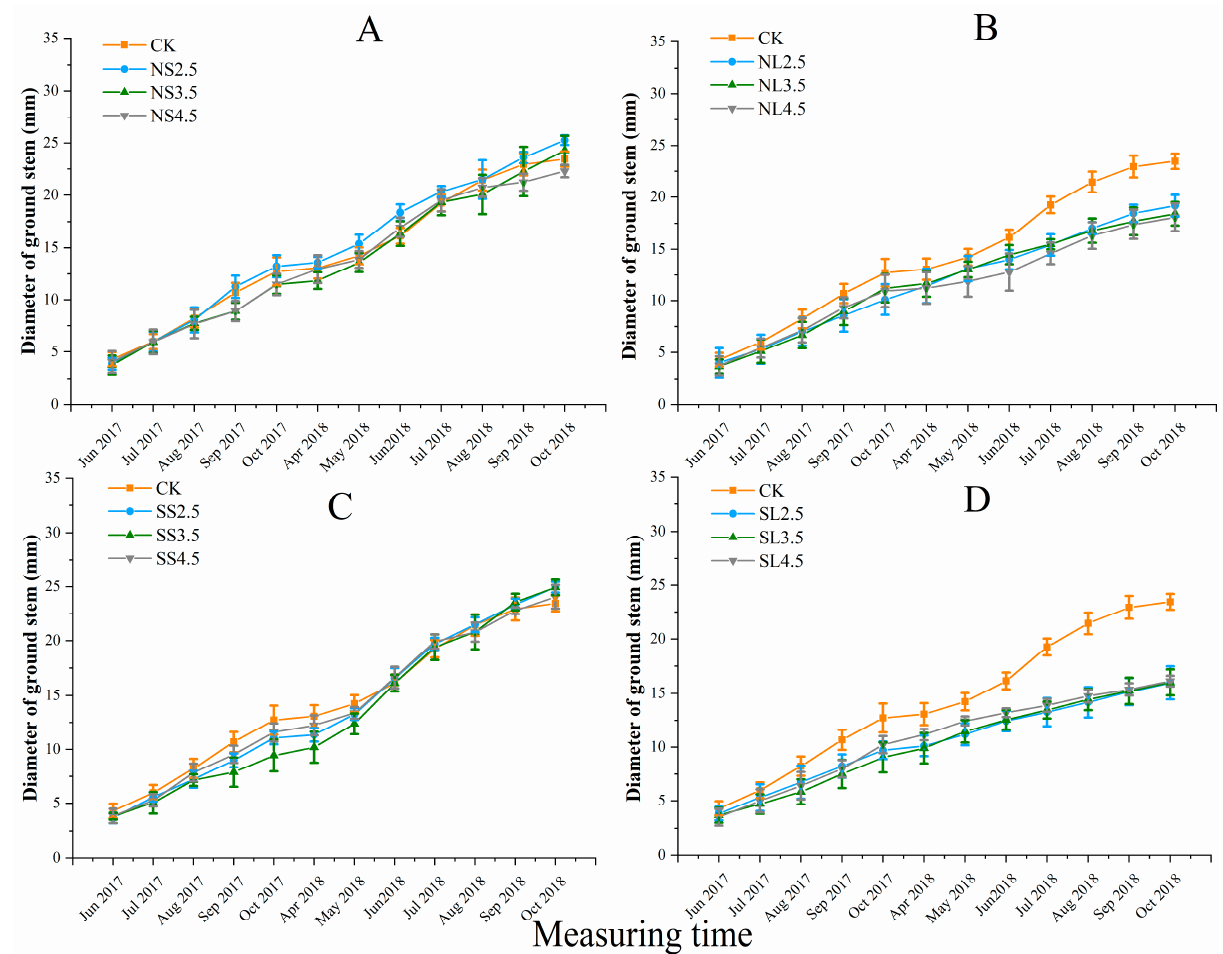
Figure 2. Effect of different forms of acid stress on diameter of ground stem (mm) of A. catalpifolium during the 16-month observation period. The treatments: CK, NS ( A ), NL ( B ), SS ( C ) and SL ( D ) are defined as control, nitric-balanced acid applied to soil, nitric-balanced acid applied to leaves, sulfuric-dominated acid applied to soil and sulfuric-dominated acid applied to leaves, respectively. Values are the average ± standard deviation (n = 10).